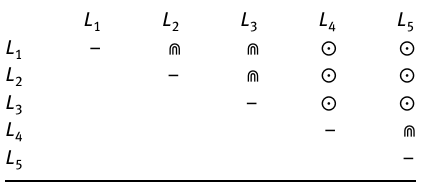
Table 9: Relation matrix of the core, illustrated in Figure 9B, of the substructure (from 800th to 900th nucleotides) PDB_00589.